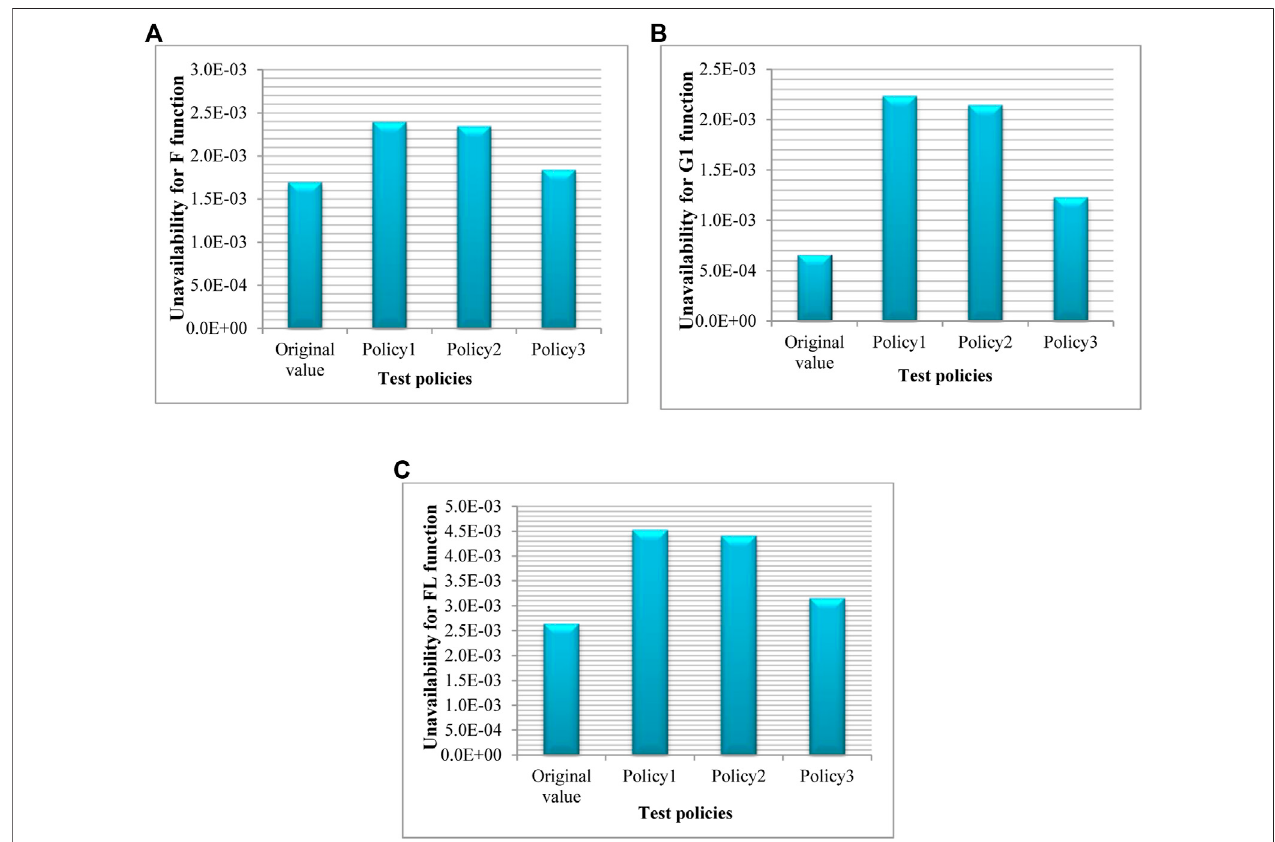
FIGURE 7 | Comparison of unavailability between different policies and original value for functions of ECCS: (A) F, (B) G1, and (C) FL.